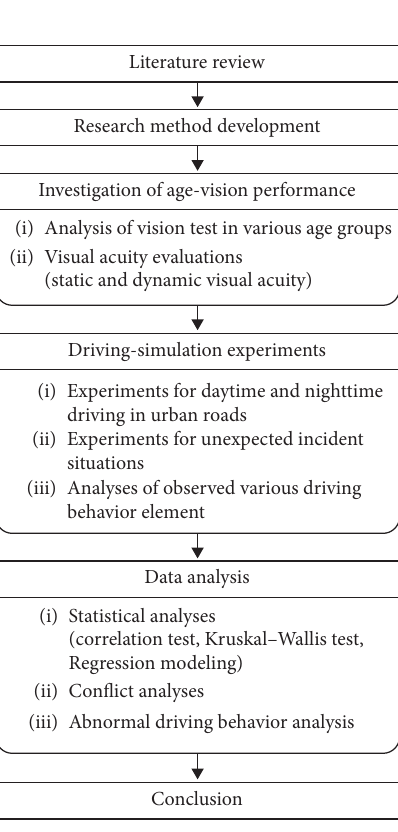
Figure 1: Flowchart of this